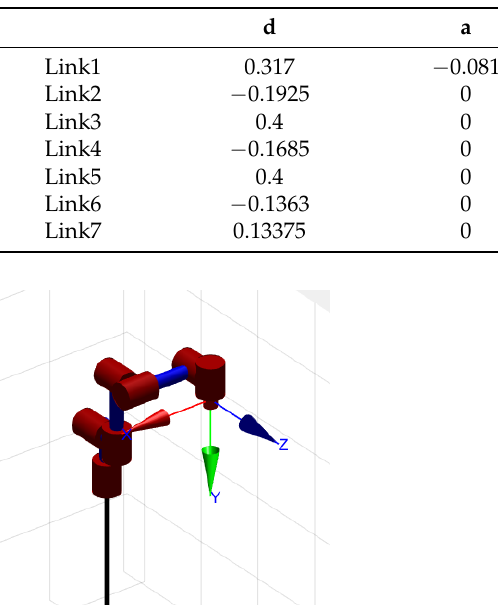
Table 1. The DH table of evaluation of sawyer.